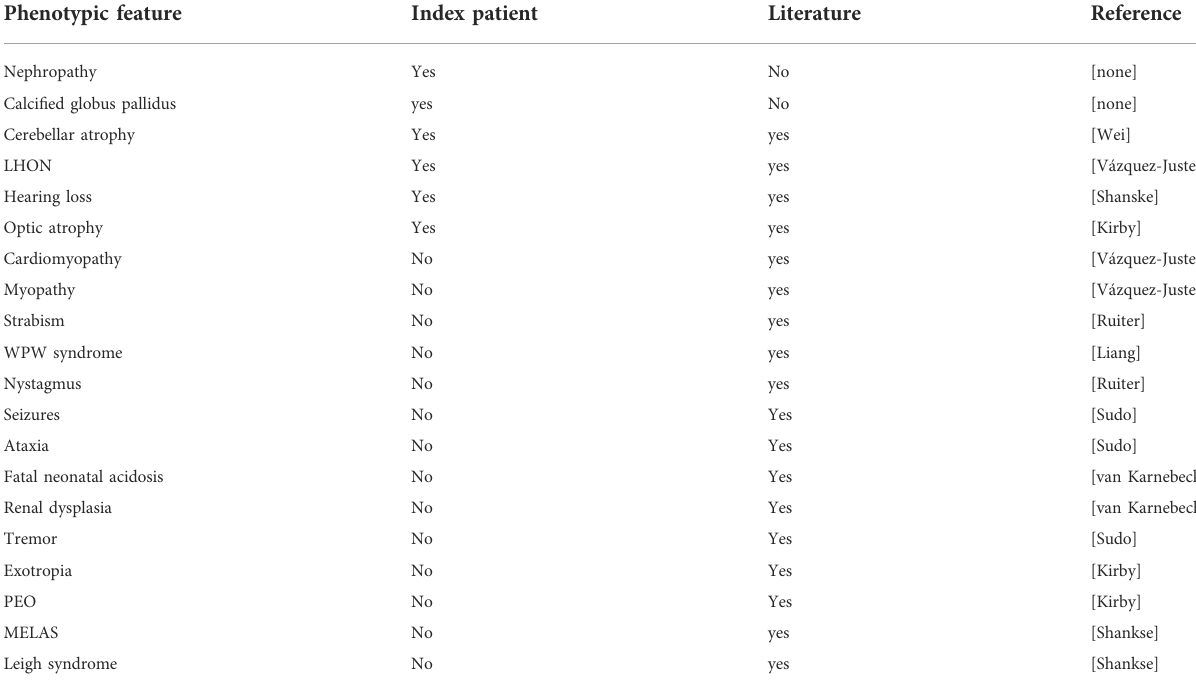
TABLE 1 Phenotypic manifestations of the variant m.13513G > A in the index patient and the literature so far reported. Phenotypic